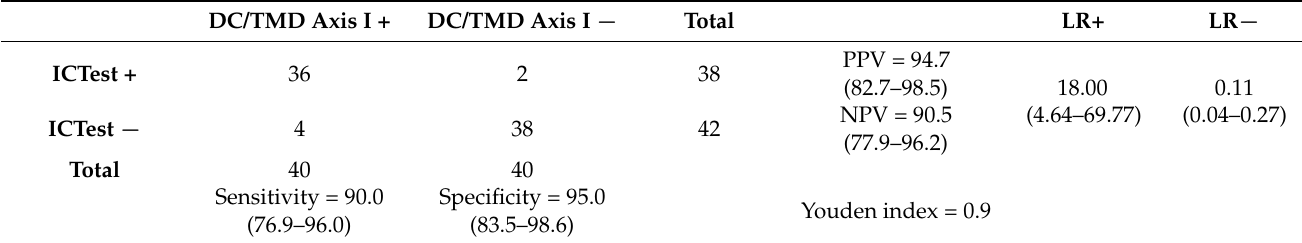
Table 1. Validity results for the ICTest with respect to DC/TMD of axis I